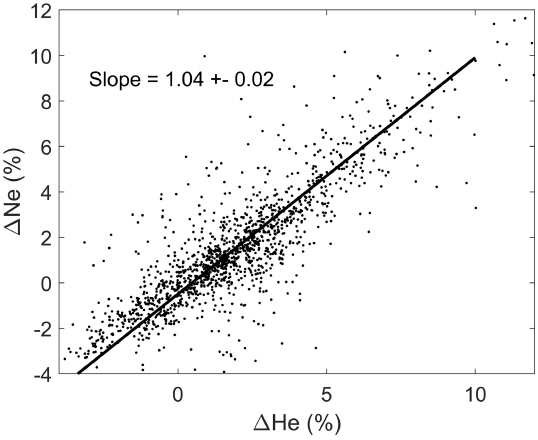
Figure 1. A scatter plot of helium and neon saturation anomalies for nearly 2000 near-surface ( < 20m depth) samples from the dataset. The solid line is a type-II linear regression of the